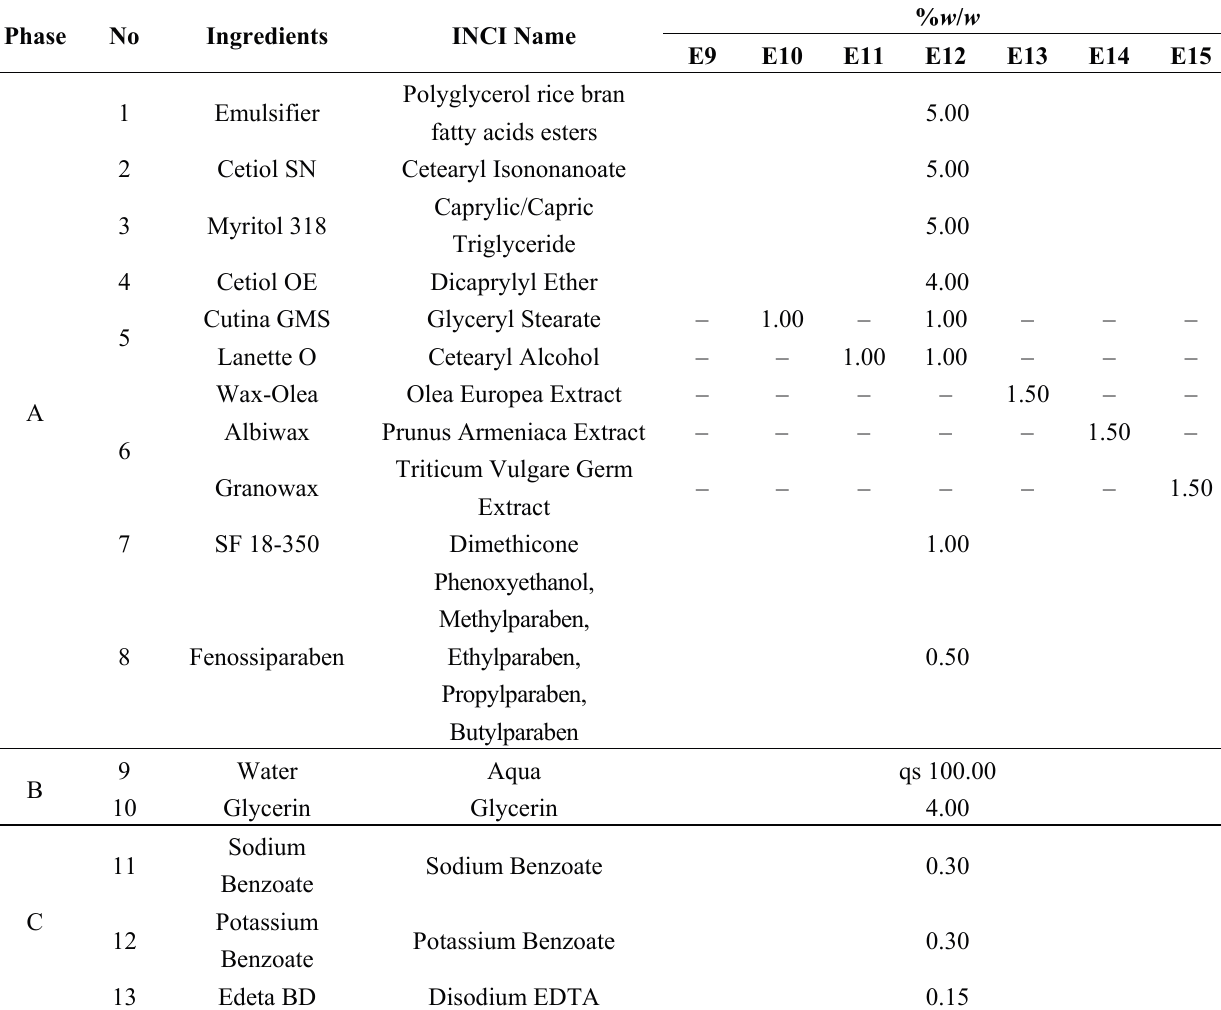
Table 5. Compositions of O/W basic emulsions containing vegetable wax and consistency factors.